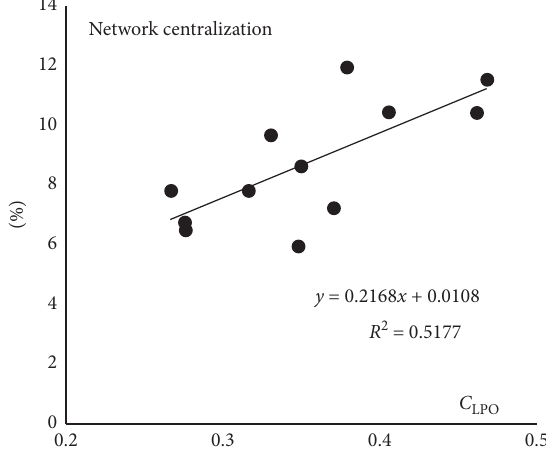
Figure 10: The relationship between C other